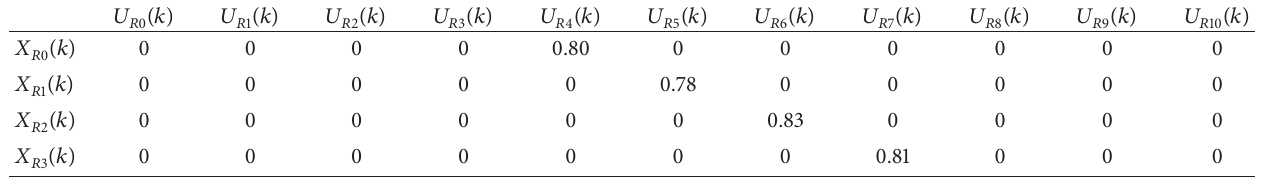
Table 16: The input matrix B 𝑅